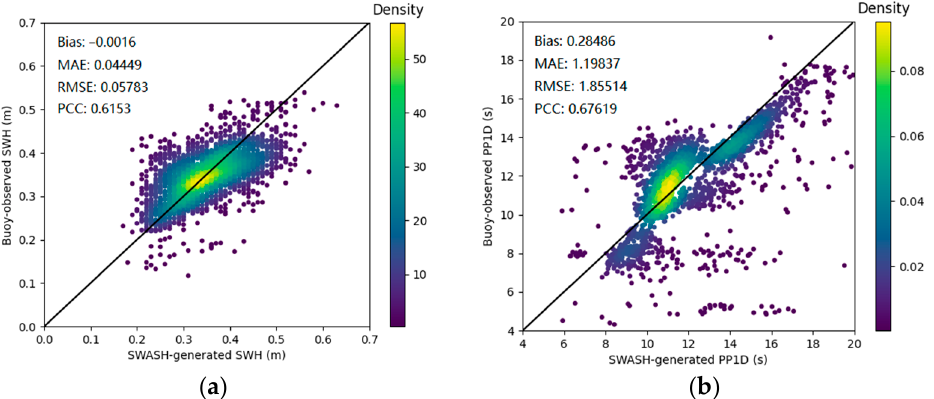
Figure 2. Comparisons between the buoy-observed data and the SWH ( a ) and PP1D ( b ) generated by the calibrated SWASH model at the ADCP1 location.